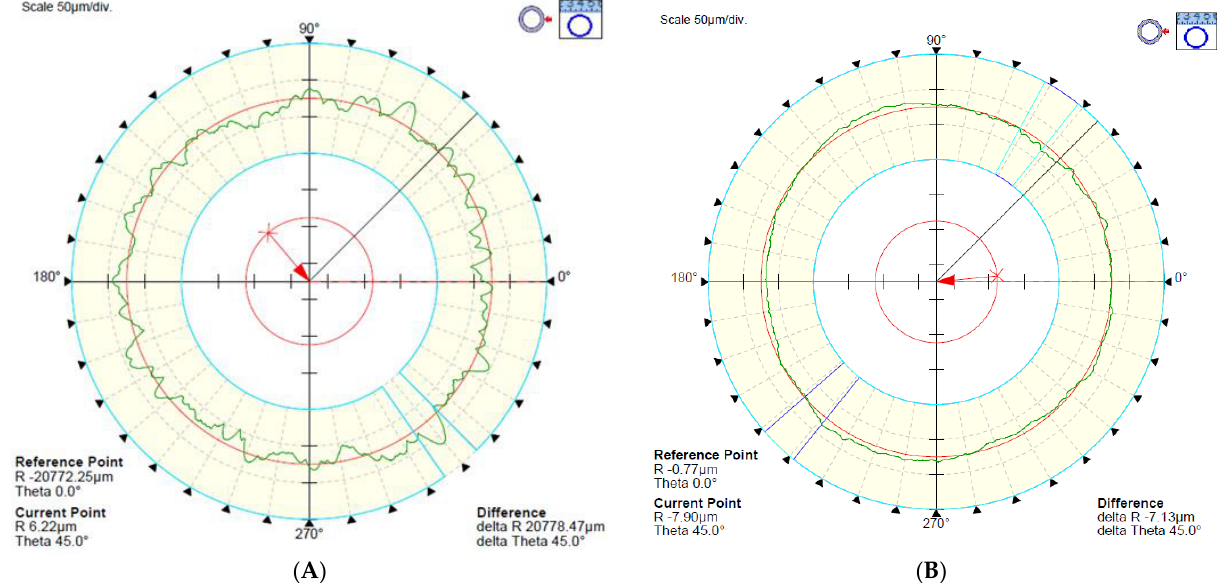
Figure 5. Cylindricity error diagram before ( A ) and after ( B ) burnishing in the middle (in the 6th measuring location) of sample E8.